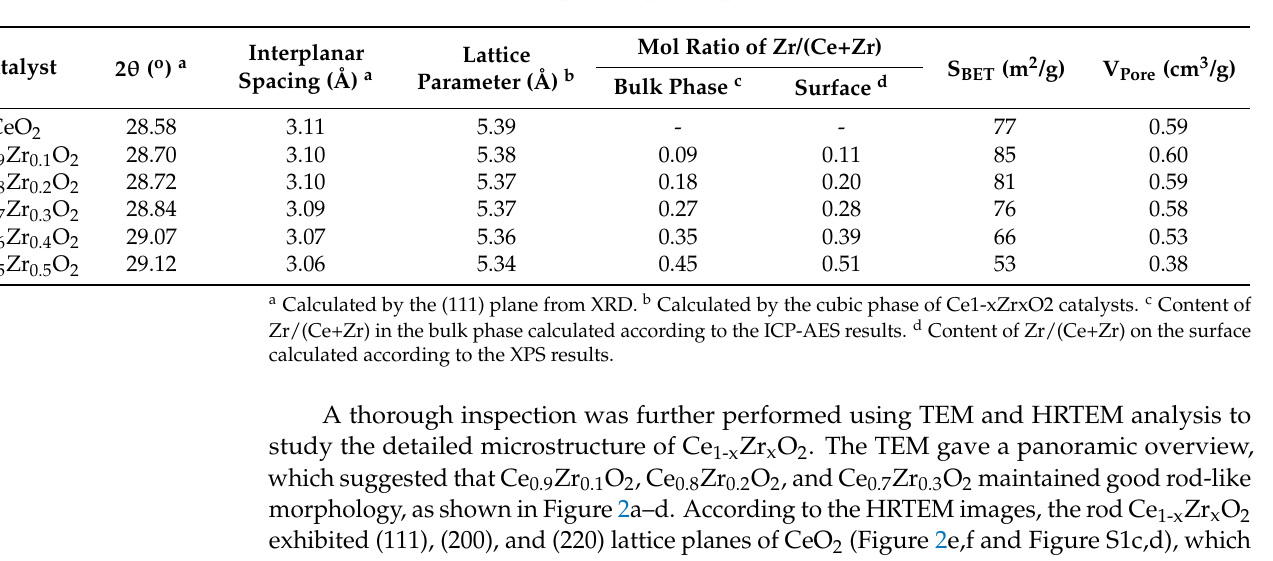
Figure 1. XRD patterns of the Ce 1-x Zr x O 2 and CeO 2 nanorods. Table 1. Textural data of CeO 2 and Ce 1-x Zr x O 2 nanorods.